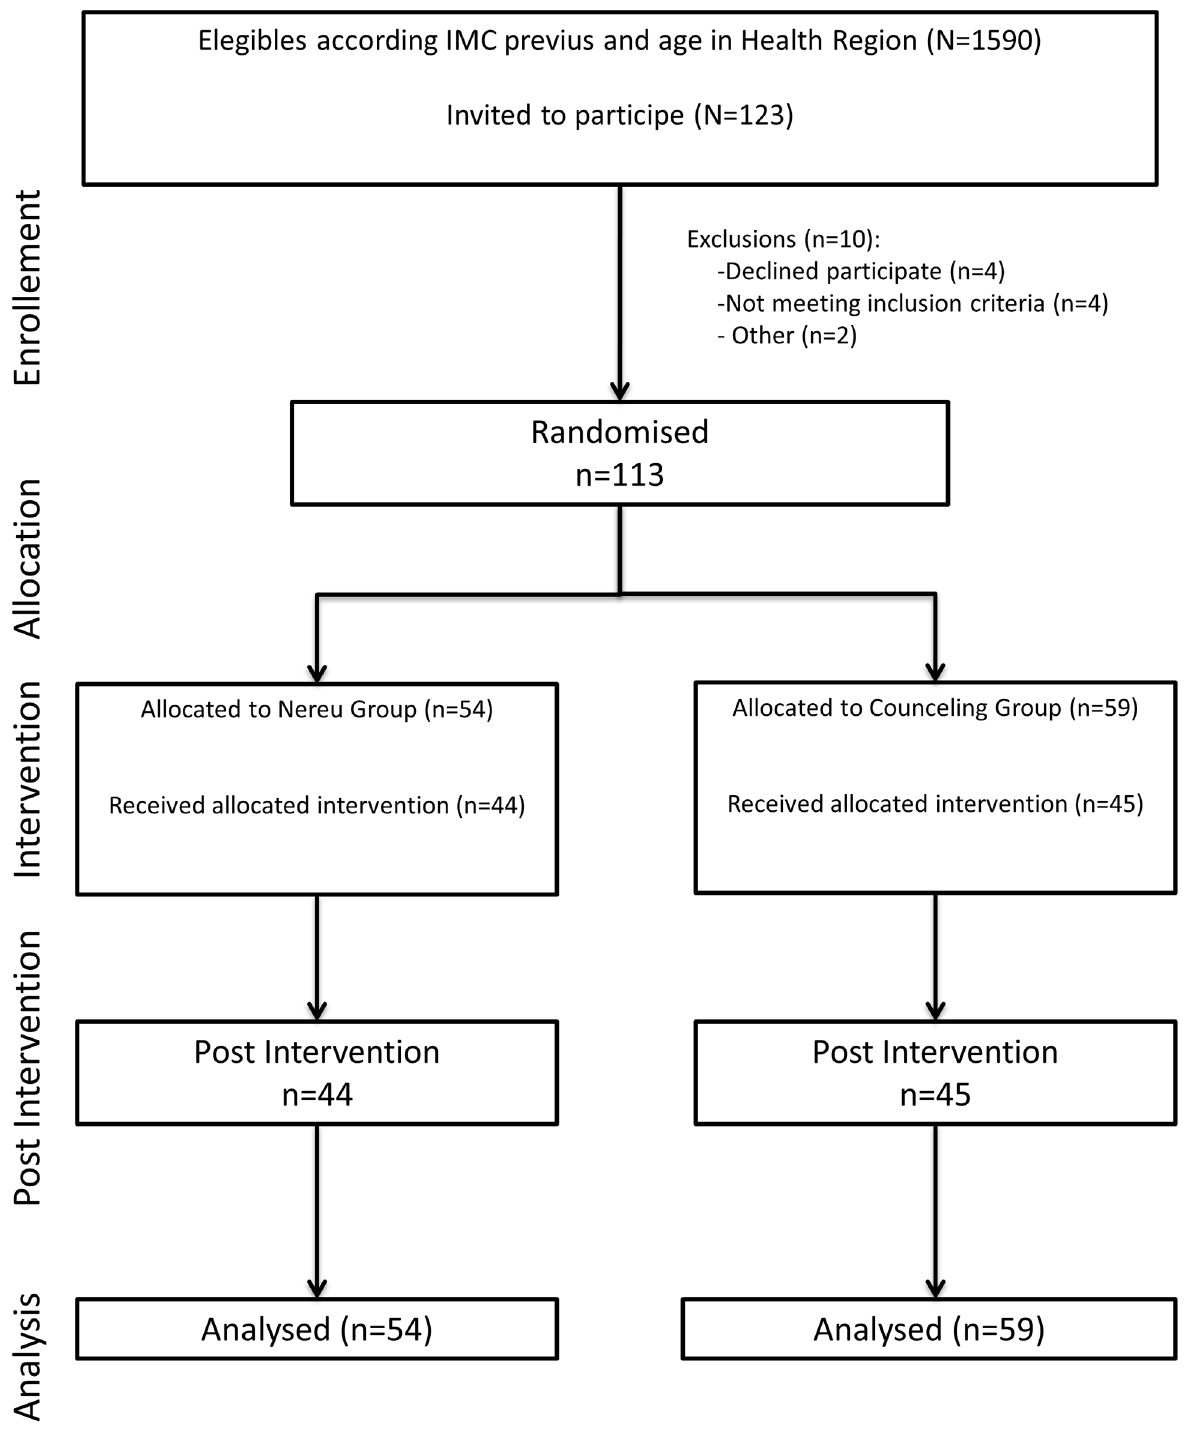
Fig 1. Flow Chart of Study Participants.